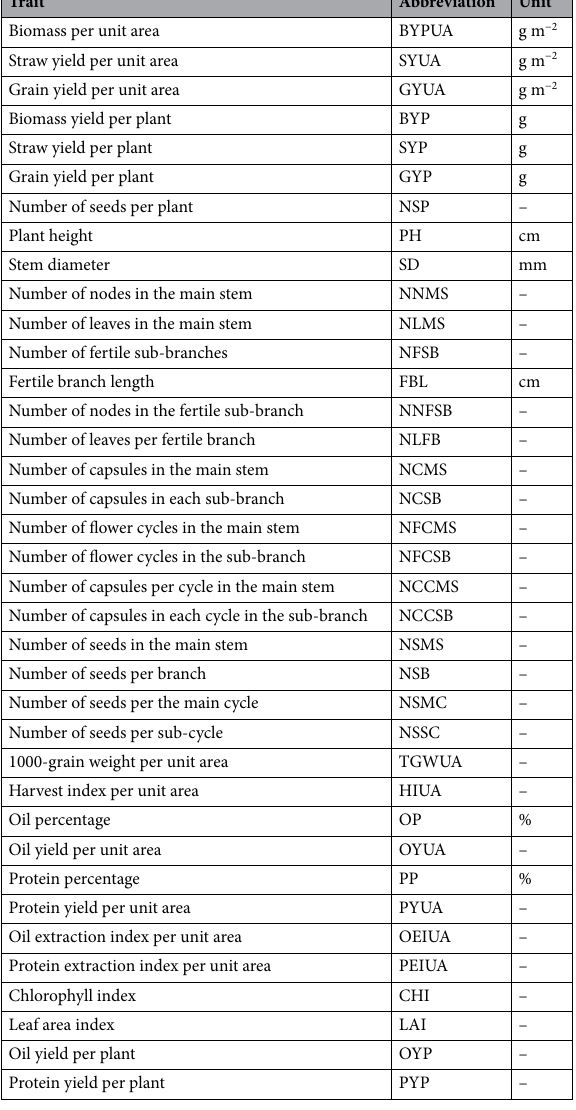
Table 1. The measured traits of the Lallemantia iberica ecotypes with corresponding abbreviations, and units of